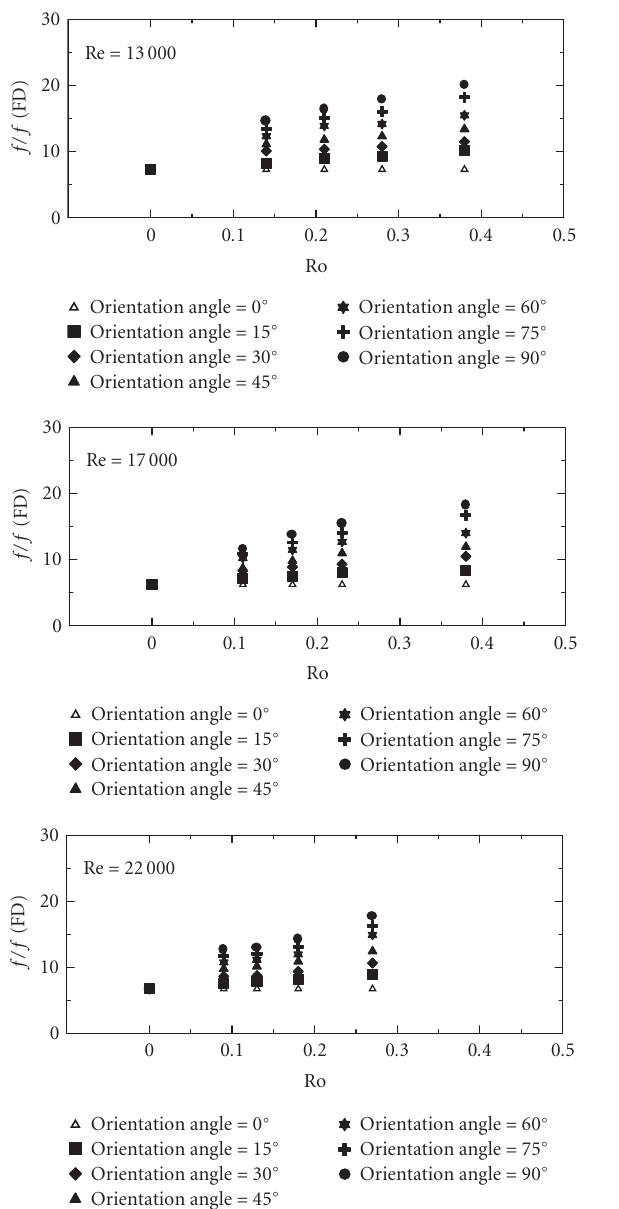
Figure 10: E ff ect of the rib pitch-to-height ratio for 90 ◦ ribbed ra- dial outward flow channel for an orientation angle of 90 ◦